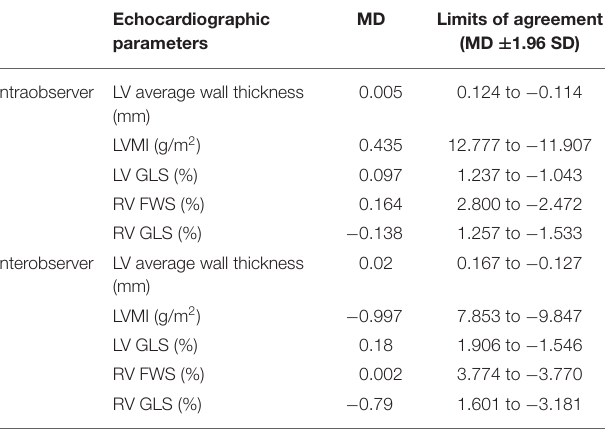
TABLE 4 | Bland–Altman analysis for intra- and interobserver variability.